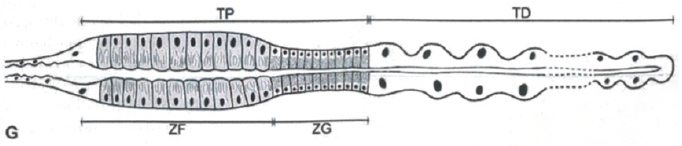
Figure 3. Representation of Machaerotidae nymphs Malpighian Tubules. TP = proximal tract, TD = distal tract, ZF = zone rich in fibrils, ZG = zone rich in granules. From Conti et al. [5].